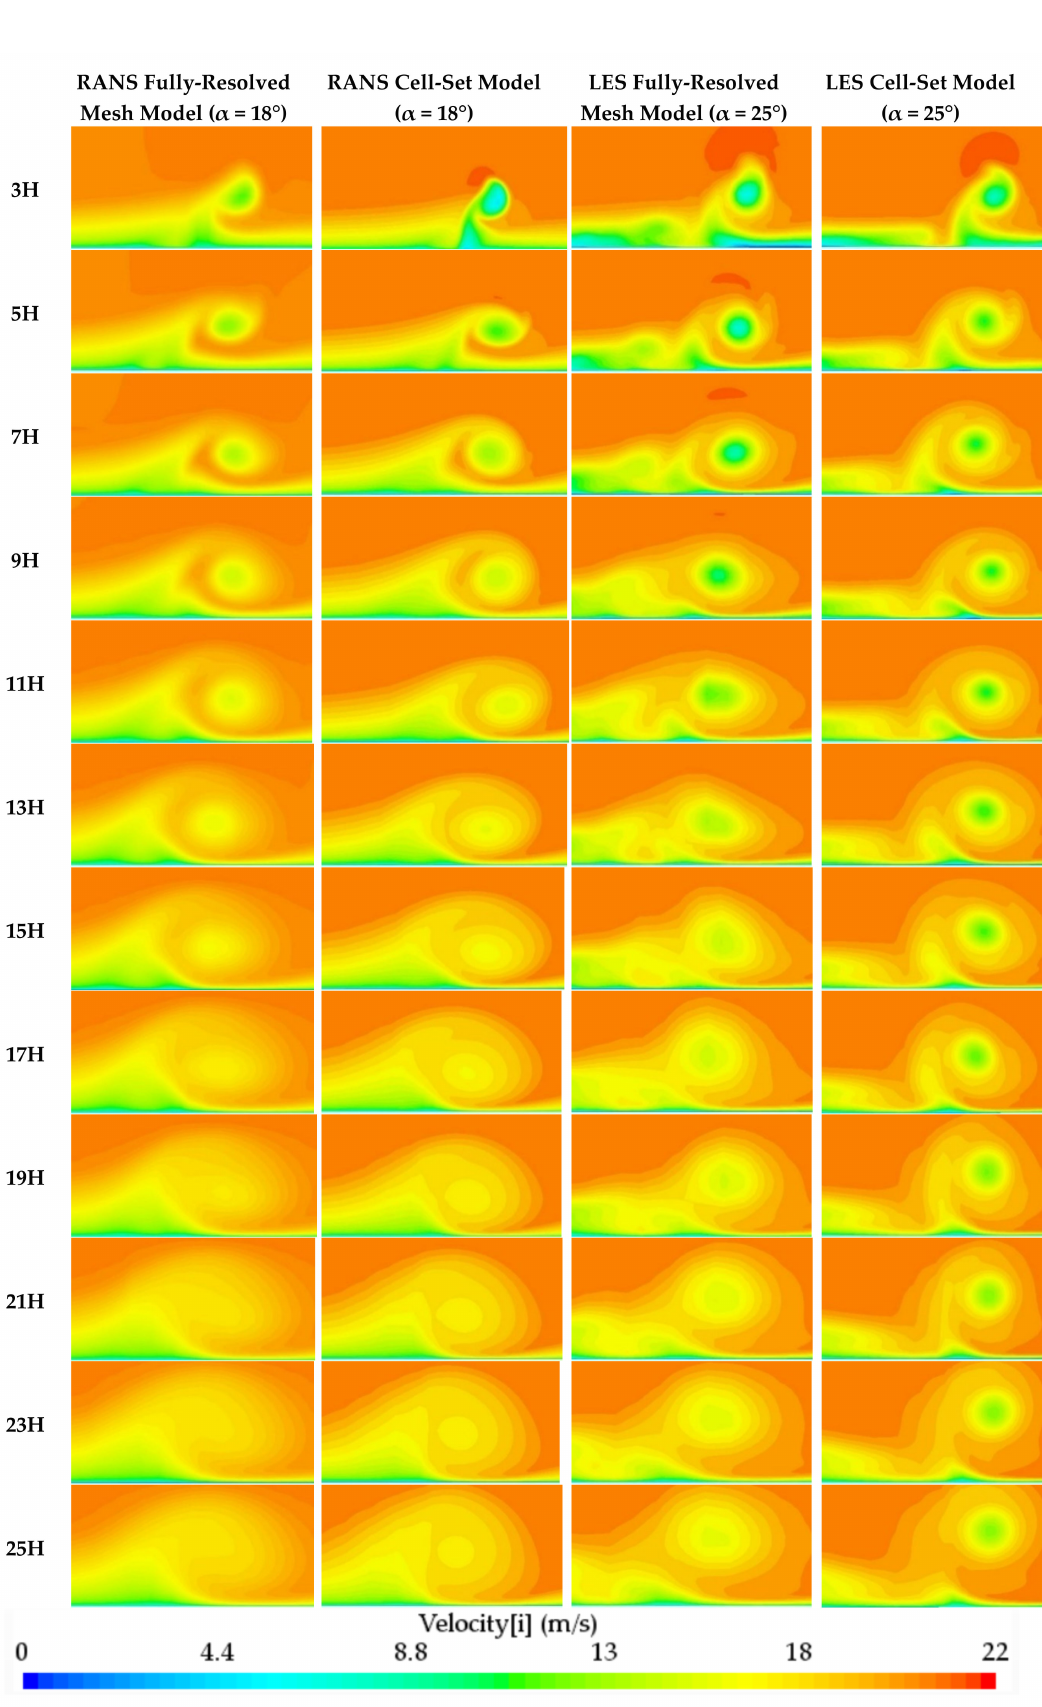
Figure 6. Axial velocity at 12 di ff erent spanwise